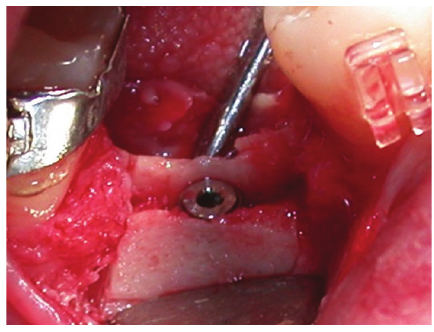
Figure 12: Clinical view after implant placement.